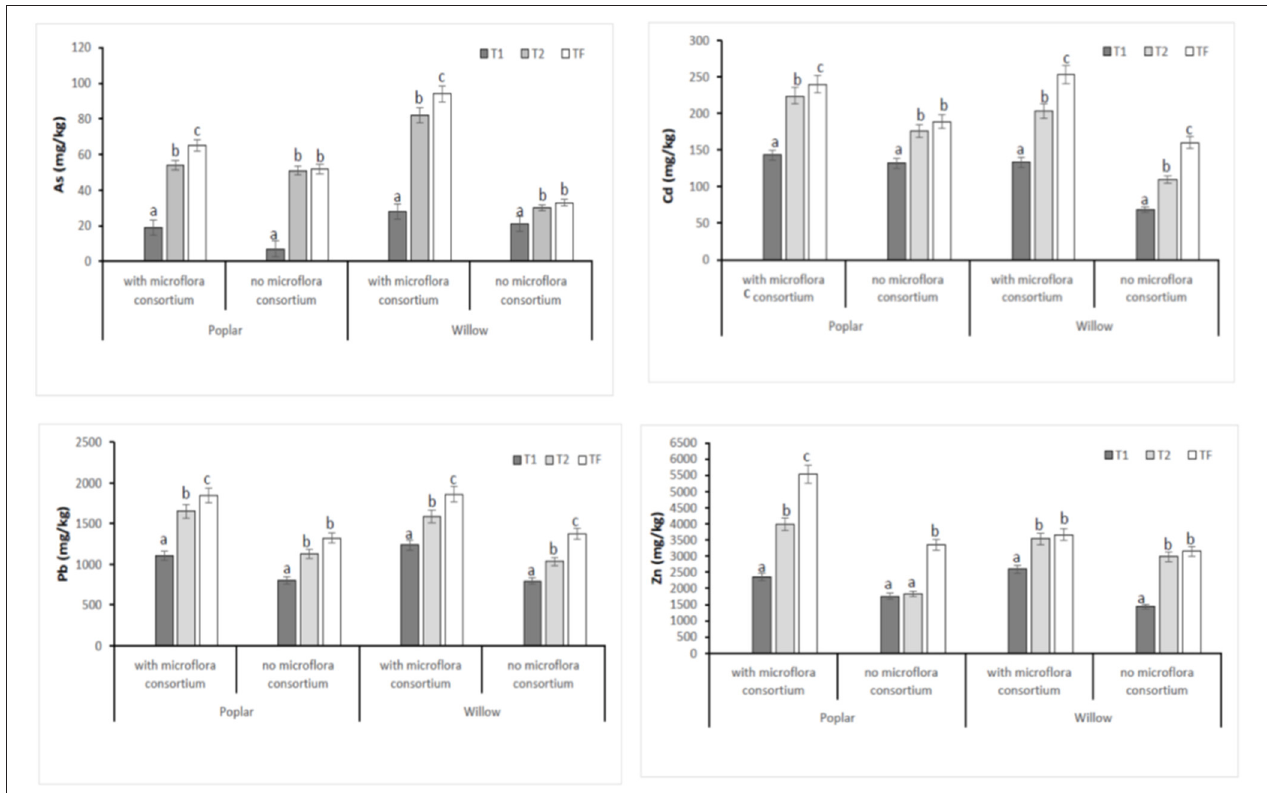
FIGURE 6 | Total concentration of HMs (As, Cd, Pb, and Zn) in roots at different monitoring time (T 0 :0, T 1 :12, T 2 :24, and T F : 36 months) with microflora consortium and no microflora consortium in hybrid poplar Populous deltoids × Populous nigra and in willow Salix purpurea subsp. lambertiana . Mean values ± SE.